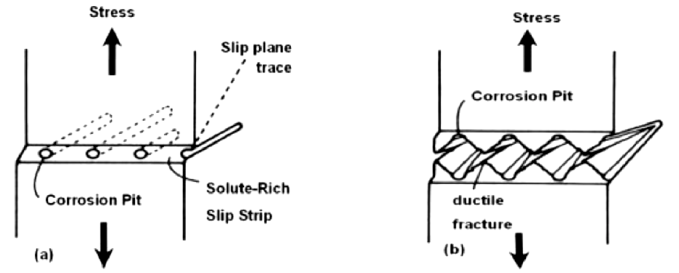
Figure 5. ( a ) Tubular pits form due to film rupture on slip steps; ( b ) crack propagation occurs by ductile